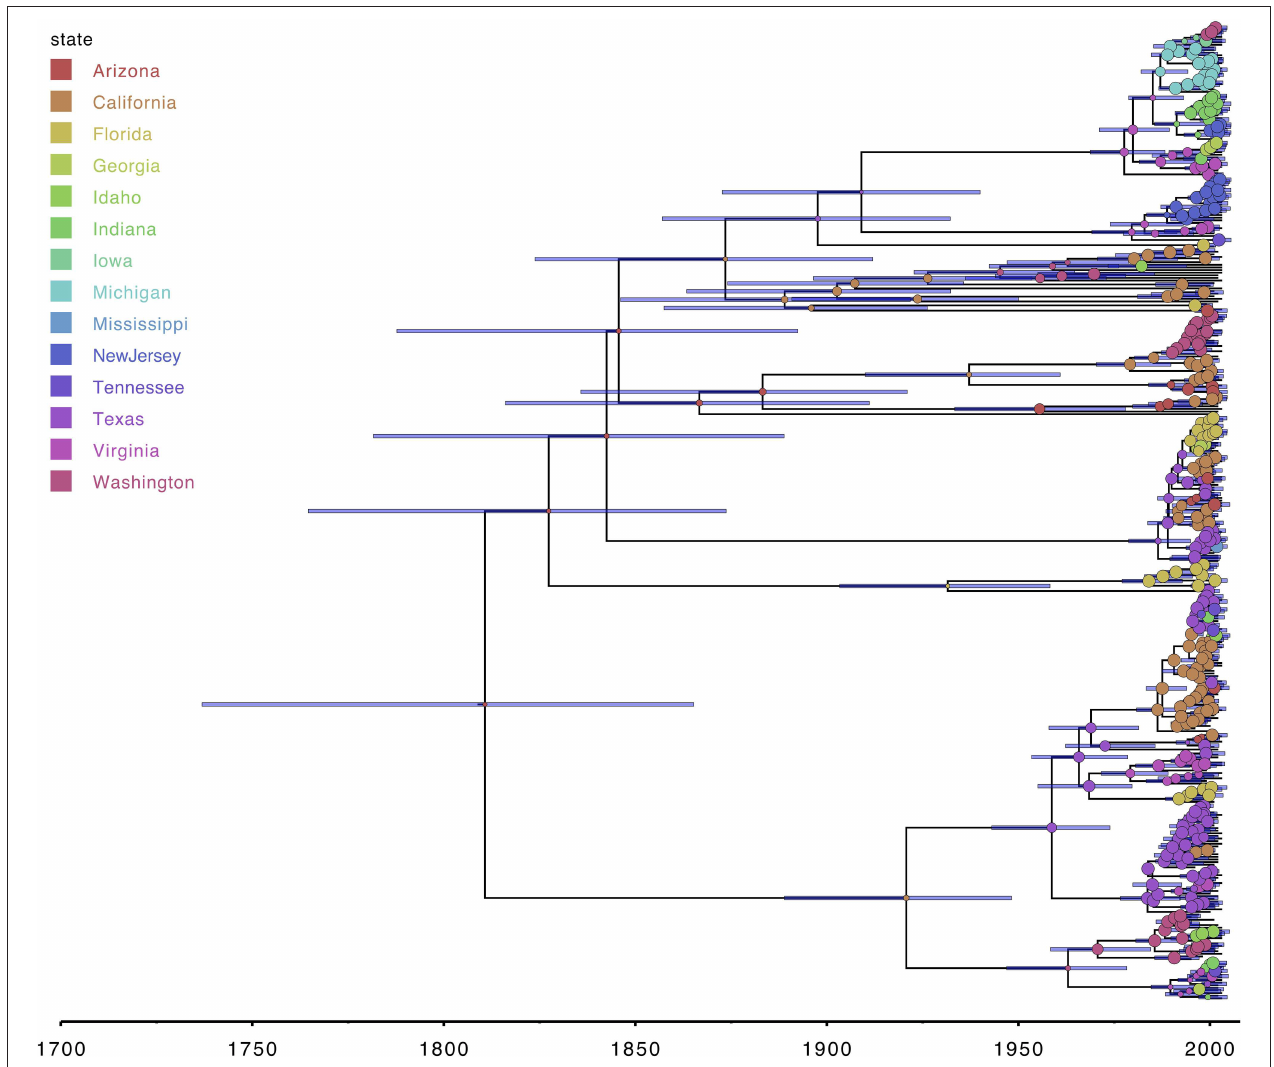
FIGURE 1 | FigTree allows visualizing various tree formats, including maximum clade credibility trees from Bayesian phylogenetic analyses (38). External and internal nodes can easily be annotated using the information in the source tree file, and the time information within the tree allows adding a time axis which facilitates interpretation. Annotations shown here for the RABV data set are the 95% highest posterior density (HPD) age intervals and the most probable ancestral location state at each internal node, with the circle width corresponding to the posterior support for the internal location state reconstruction.